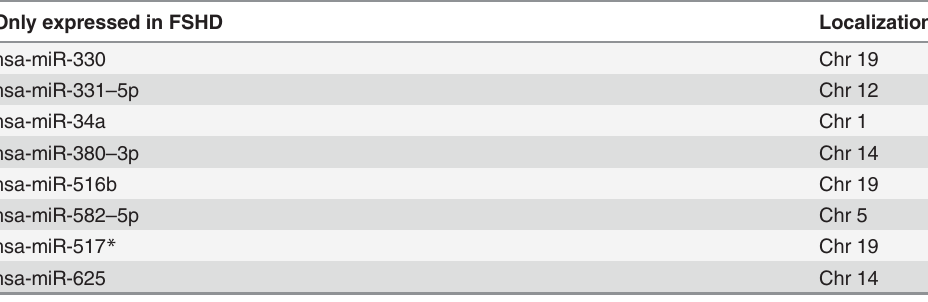
Table 3. microRNAs exclusively expressed in FSHD